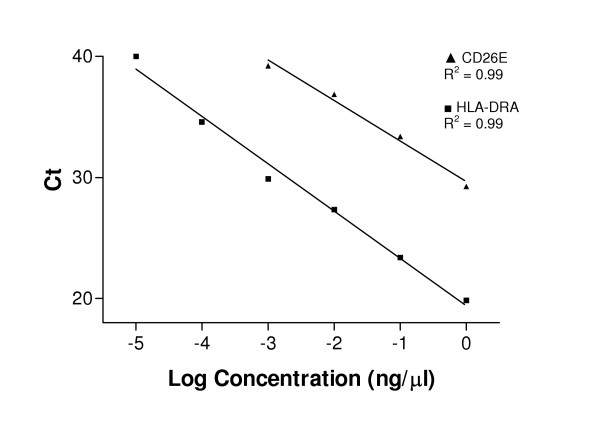
Measurement by LDA of mRNA's for two genes (CD26E and HLA-DRA) derived from a 10-fold dilution series of tonsil cDNA. Each data point represents the mean Ct (copy threshold) value derived from quadruplicate measurement of each sample dilution. A line of best fit and R2 value were derived using PRISM software.